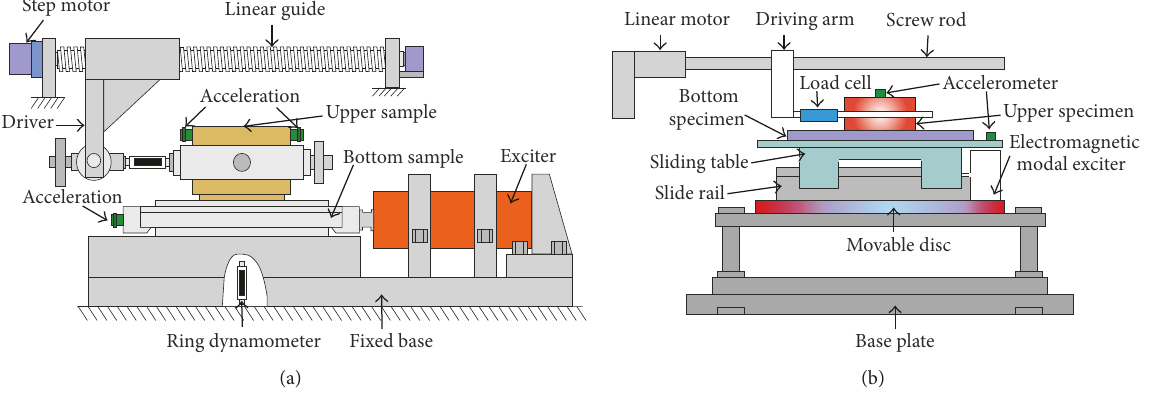
Figure 8: Sliding friction experimental setups considering vibration effect: (a) reproduced after Leus and Gutowski [23]; (b) reproduced after Wang et al.